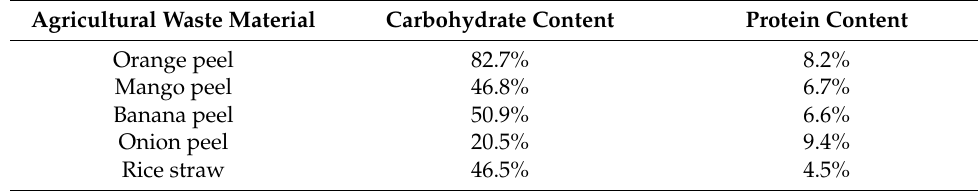
Table 5. The carbohydrate and protein content of agricultural waste material.